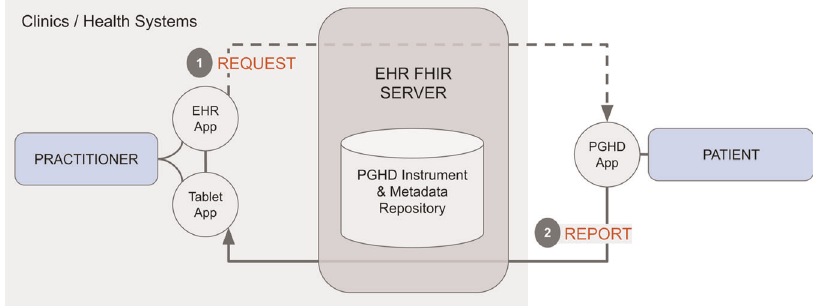
Fig. 1 PGHD apps connected through an EHR FHIR server. (1) Practitioner-facing apps dispatching PGHD requests through an EHR app or a Tablet app used in clinics or health systems. (2) Patient-facing apps for generating and reporting practitioner requested PGHD.